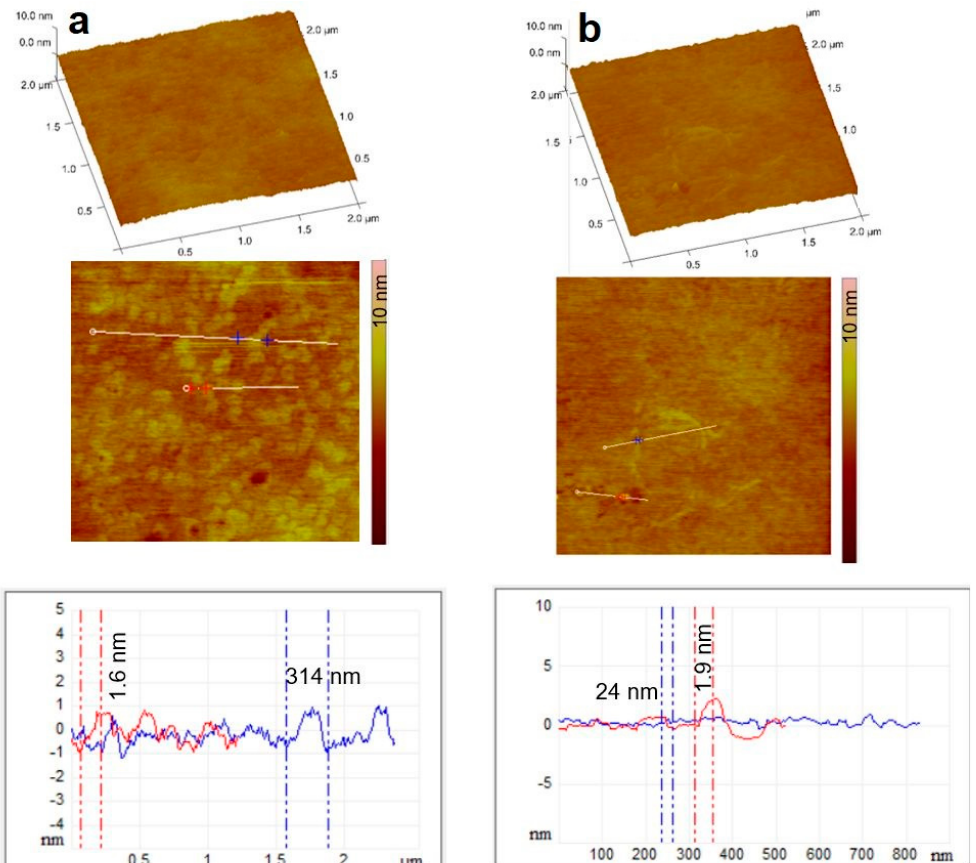
Figure 8. 3D representation, amplitude AFM images of film containing cetirizine HCl ( a ) and diclofenac Na ( b ) surfaces with the section analysis curves shown along the indicated white, blue, and red lines. In the films, the ascorbic acid content was 2%.